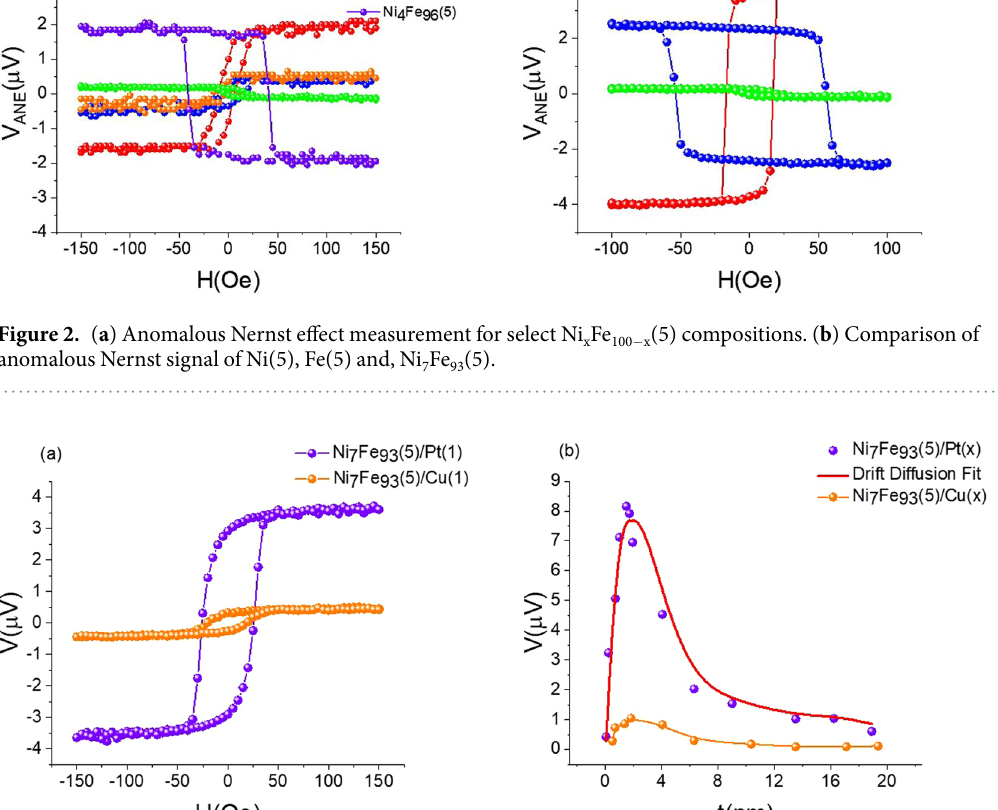
from the sample. Fabricated samples were defined into 15 mm × 2 mm pieces and pasted on to a thick Cu block using thermal grease. Heater is placed on top and maintained at fixed power. As shown in Fig. 1(b), the measured ANE signal is linear with the heater power. Figure 2(a) shows the anomalous Nernst measurements for select Ni x Fe 100 − x (5) (number in the parentheses is the thicknesses in nanometers) nominal compositions. By tuning the composition of the alloy Ni x Fe 100 − x , where we invoke the competition between opposite anomalous Nernst signals of constituent elements, achieved zero Nernst coefficient in Ni 7 Fe 93 at a thickness of 5 nm . Figure 2(b) compares the anomalous Nernst signal of optimized composition Ni 7 Fe 93 (5) with that of pure Ni(5) and Fe(5). Optimized composition has a profile similar to pure Fe and an anomalous Nernst coefficient at least 20 times smaller than that of Ni or Fe, and hence considered here as the “zero Nernst material”. In Fig. 3(a), a representative curve of Ni 7 Fe 93 (5)/Pt(1) is shown. When a HM, Pt is placed adjacent to Ni the same polarity as pure Fe. As a comparison, the curve for a control sample Ni 7 Fe 93 (5)/Cu(1) is shown in the same figure with a signal 20 times smaller. An electric field arises in Pt due to the ISHE,